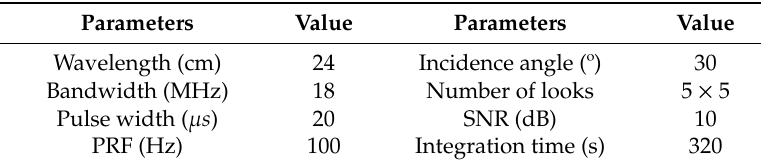
Table 2. Parameters for InSAR processing simulation.